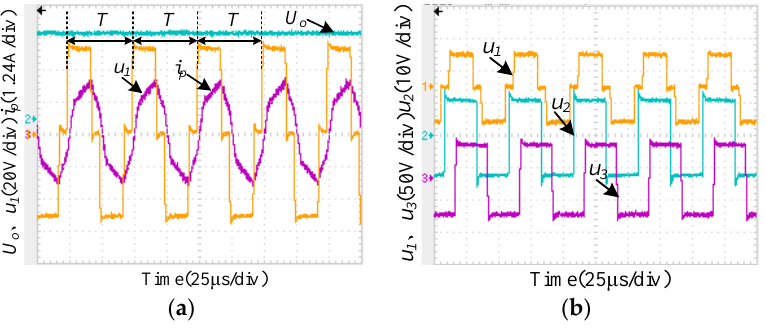
Figure 25. Measured waveforms of phase-shifted PWM control using fixed switching frequency: ( a ) converter voltage, current of port 1 and output voltage of port 2; ( b ) converter voltages of port 1, 2 and 3.